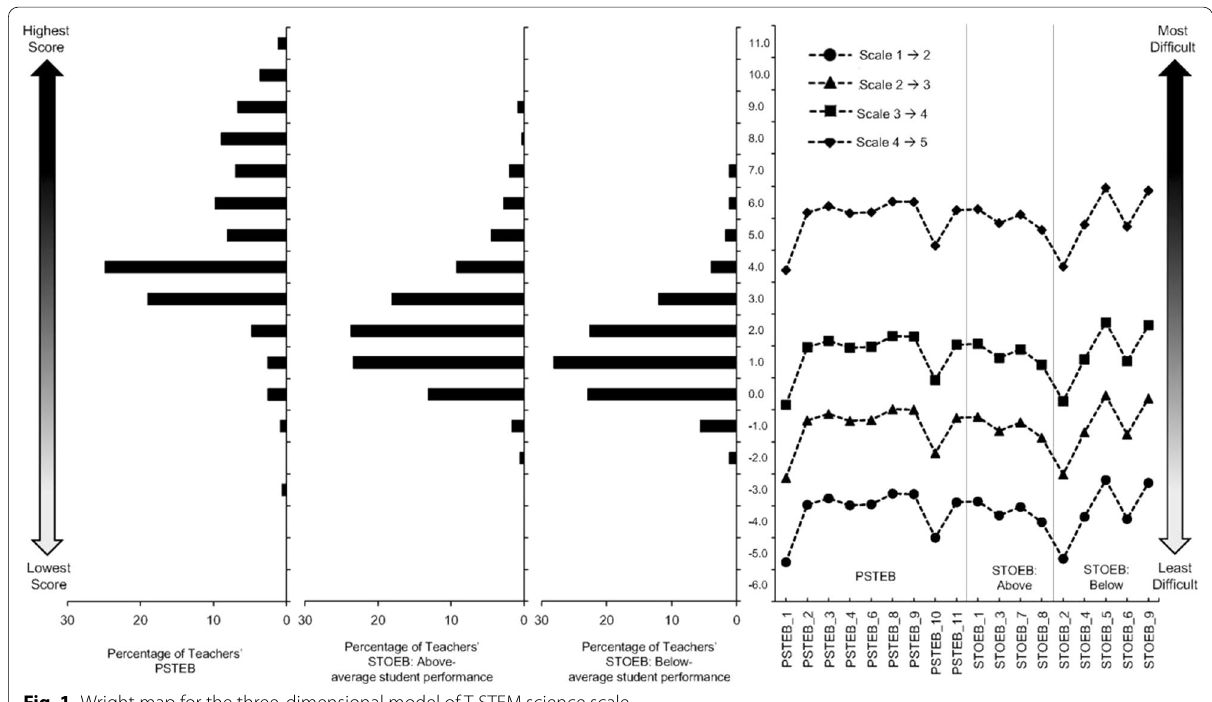
Fig. 1 Wright map for the three-dimensional model of T-STEM science scale